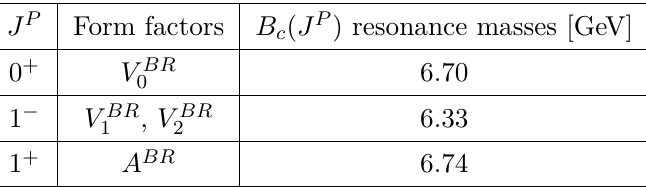
Table 3 . The lowest-lying B c ( J P ) resonances in the form factor parametrizations. The masses are taken from the refs. [6,